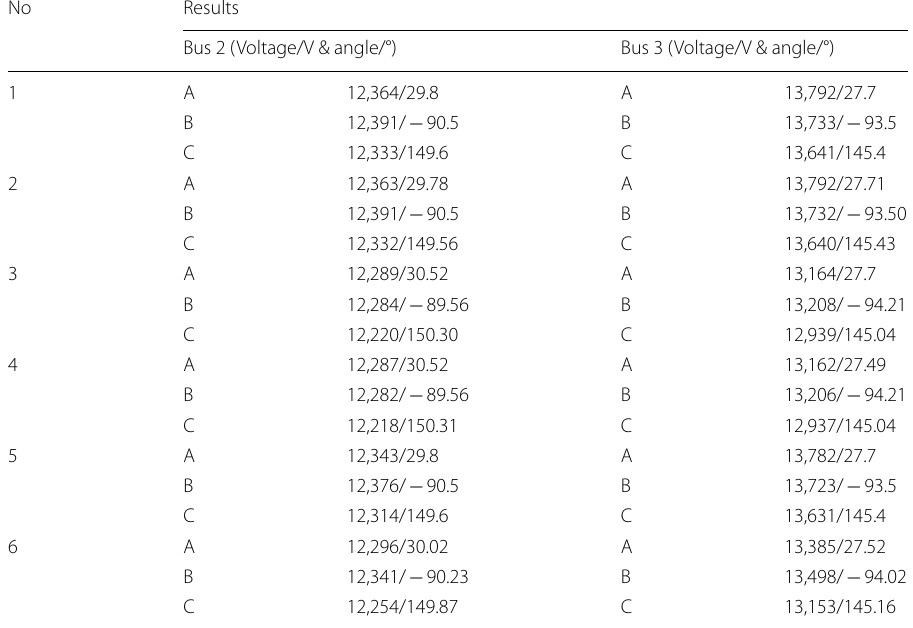
Table 3 Results of power flow calculations for the transformer in D, yn1 connection No